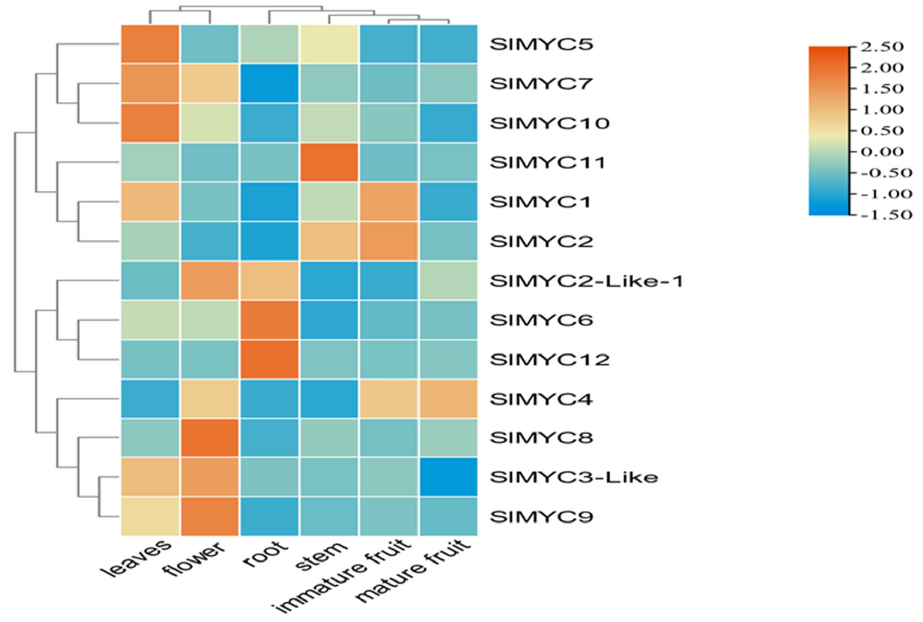
Figure 5. Response analysis of SlMYC genes in the roots, stems, leaves, flowers, immature fruit, and mature fruit by qRT − PCR. RNA samples were extracted from different tissues of tomato.